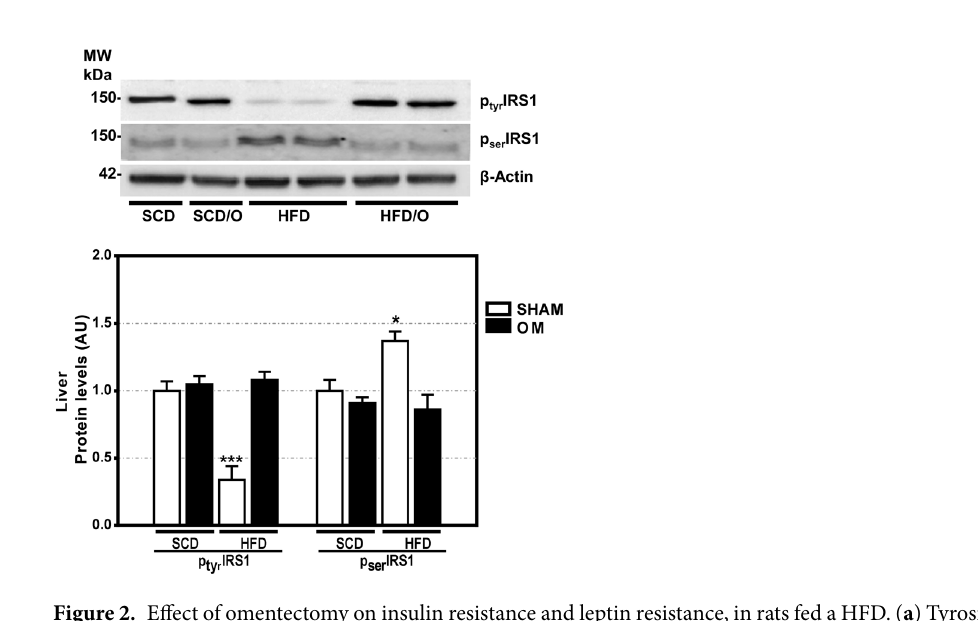
3-tyrosine nitrated proteins levels, as well as protein expression of iNOS and CHOP, (Fig. 4d) were also normal in this group of rats. In HFD/O2-rats, that is, in rats undergoing omentectomy after two months on a HFD, food intake decreased significantly two months after surgery, and weight gain ceased immediately after omentectomy despite contin- uing on the same diet. Sixty days after surgery, body weight decreased significantly and this decrease persisted throughout the experimental period (Table 2). Likewise, omentectomy was followed by a significant decrease in HOMA-IR and in plasma glucose, triglyceride, and insulin levels (Table 2). Moreover, steatosis grade (Fig. 3f–j), hepatic triglycerides, and inflammation, apoptosis, and fibrogenesis markers also decreased significantly over the months following omentectomy (Table 2). Predictably, SCD2-rats endocrine parameters did not differ from SCD-rats control group. Interestingly, omentectomy in rats on a SCD had no effects on weight gain or on other features of MS (Table 1; Fig. 1a).